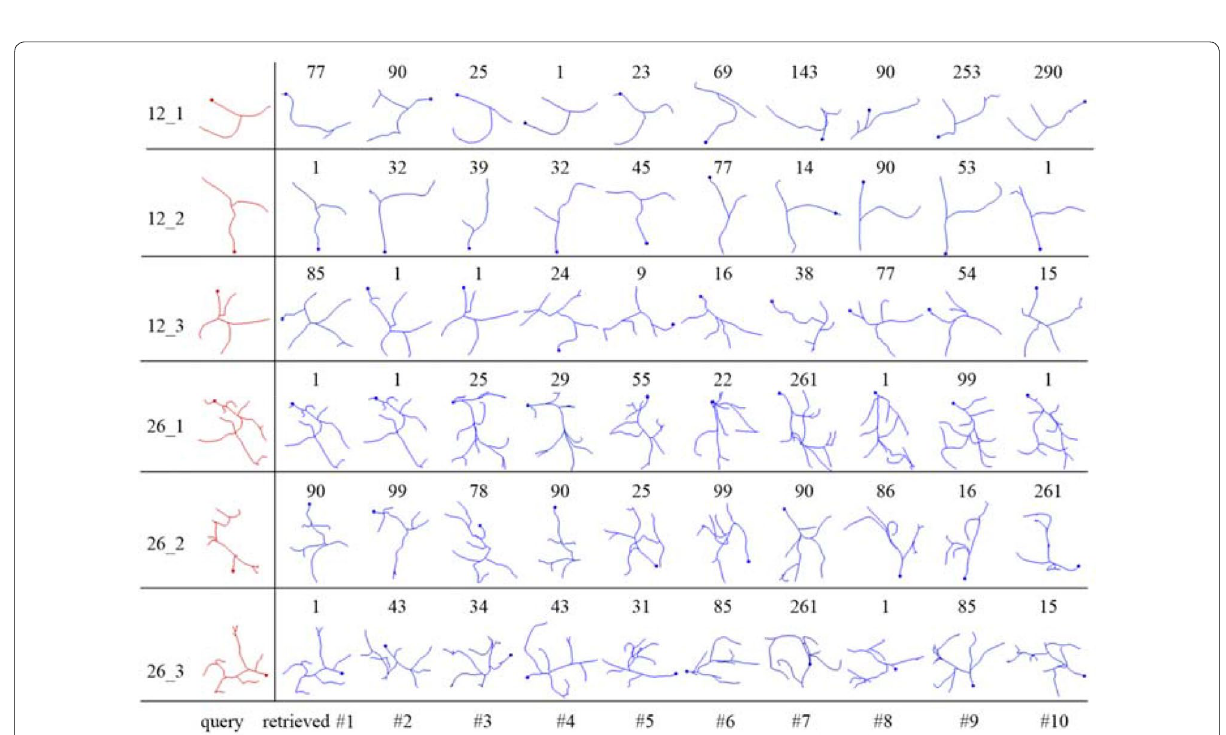
Fig. 7 Retrieved substructures on gold standard reconstructions in gold166 dataset. Three queries from two neurons (numbered 12 and 26) are in red, and their top 10 similar substructures retrieved by MS are in blue. The number above each substructure is the number of the neuron in which the retrieved substructure